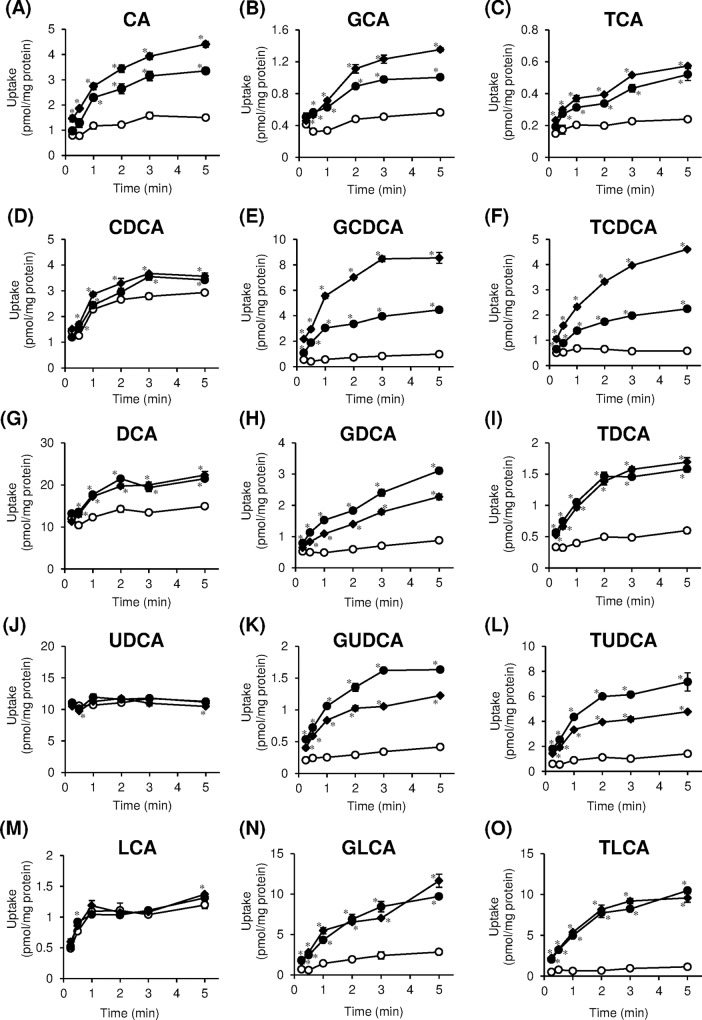
Time-dependent uptake of bile acids by organic anion-transporting polypeptides (OATP) 1B1 and OATP1B3.OATP1B1-overexpressing (closed circles), OATP1B3-overexpressing (closed diamonds), and vector-transfected (open circles) HEK293 cells were incubated for indicated times at 37°C. (A) CA (5 μM), (B) GCA (2.5 μM), (C) TCA (1 μM), (D) CDCA (0.1 μM), (E) GCDCA (1 μM), (F) TCDCA (0.5 μM), (G) DCA (1 μM), (H) GDCA (1 μM), (I) TDCA (1 μM), (J) UDCA (1 μM), (K) GUDCA (1 μM), (L) TUDCA (2.5 μM), (M) LCA (0.01 μM), (N) GLCA (0.2 μM), (O) TLCA (0.2 μM). Each point represents the mean±S.E. (n = 3). *p < 0.05, significantly different from vector-transfected cells by Student’s t-test.